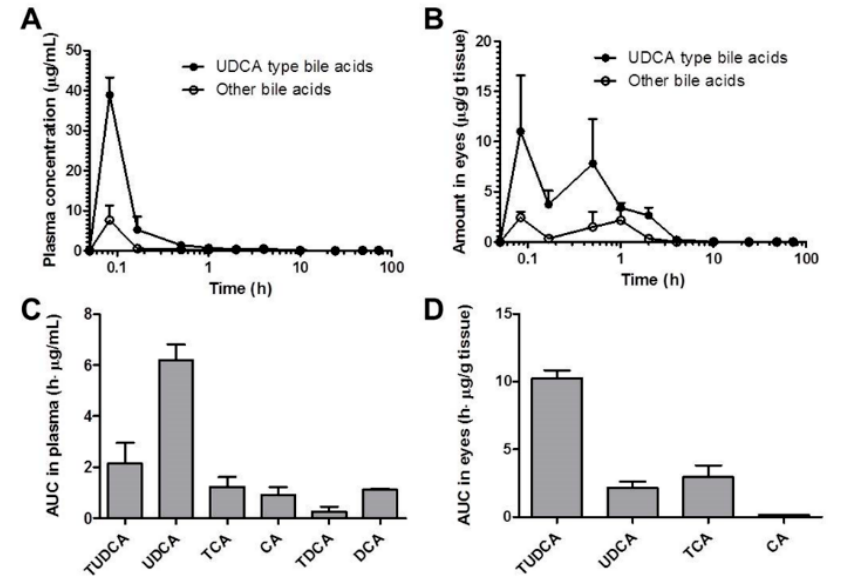
Figure 7. Average concentration and area under the bile concentration-time curve (AUC) of UDCA and other bile acids in plasma ( A ) or eyes ( B ) after the oral administration of YSB201 (125 mg/kg). AUC values ( C , D ) were calculated up to 48 h after the drug administration by the noncompartmental analysis of Pharsight ® WinNonlin program (Certara L.P., Princeton, NJ, USA).